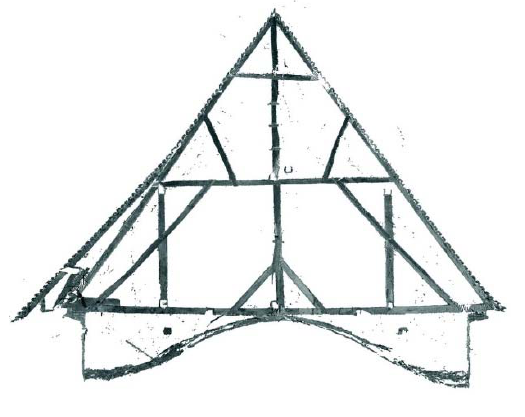
Figure 2. Hand sketch, truss of nave, fortified church, Arbegen, Transylvania © Brunner, Malik, Staudinger 2014